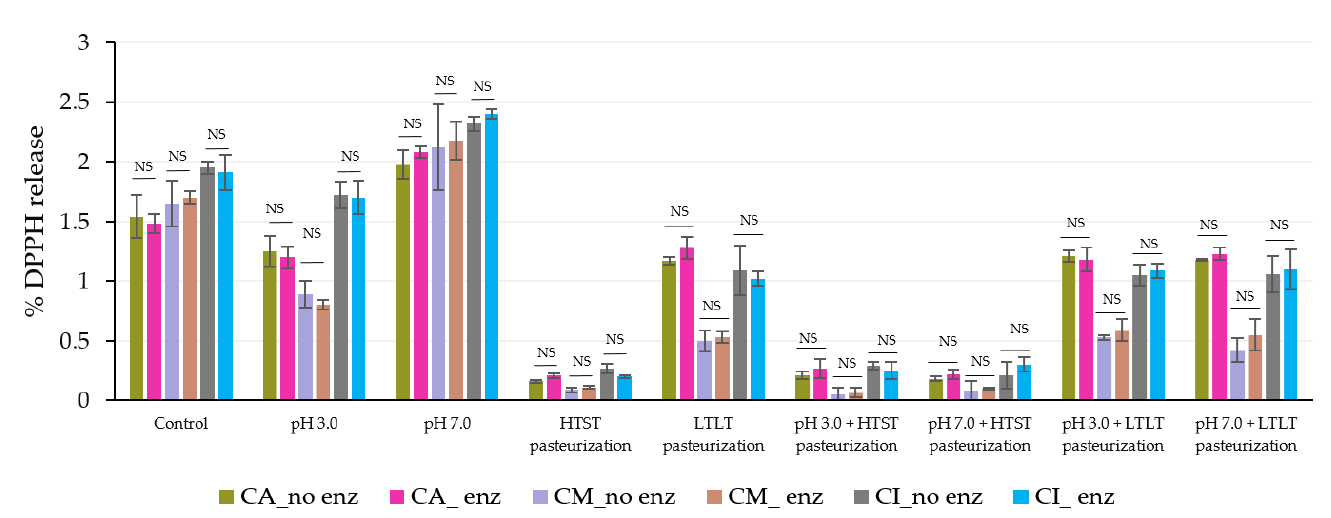
Figure 7. % DPPH released during simulated gastrointestinal conditions in the oral phase with and without salivary amylase. NS indicated no significant differences at p ≤ 0.05. The error bars indicate the SD of the data. The control sample was microbeads after air-drying.